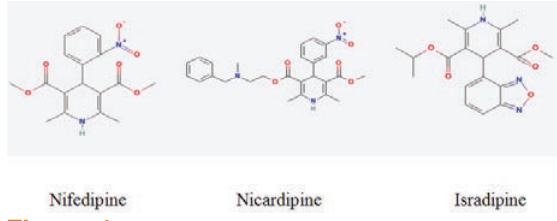
Figure 1. Structures of the studied